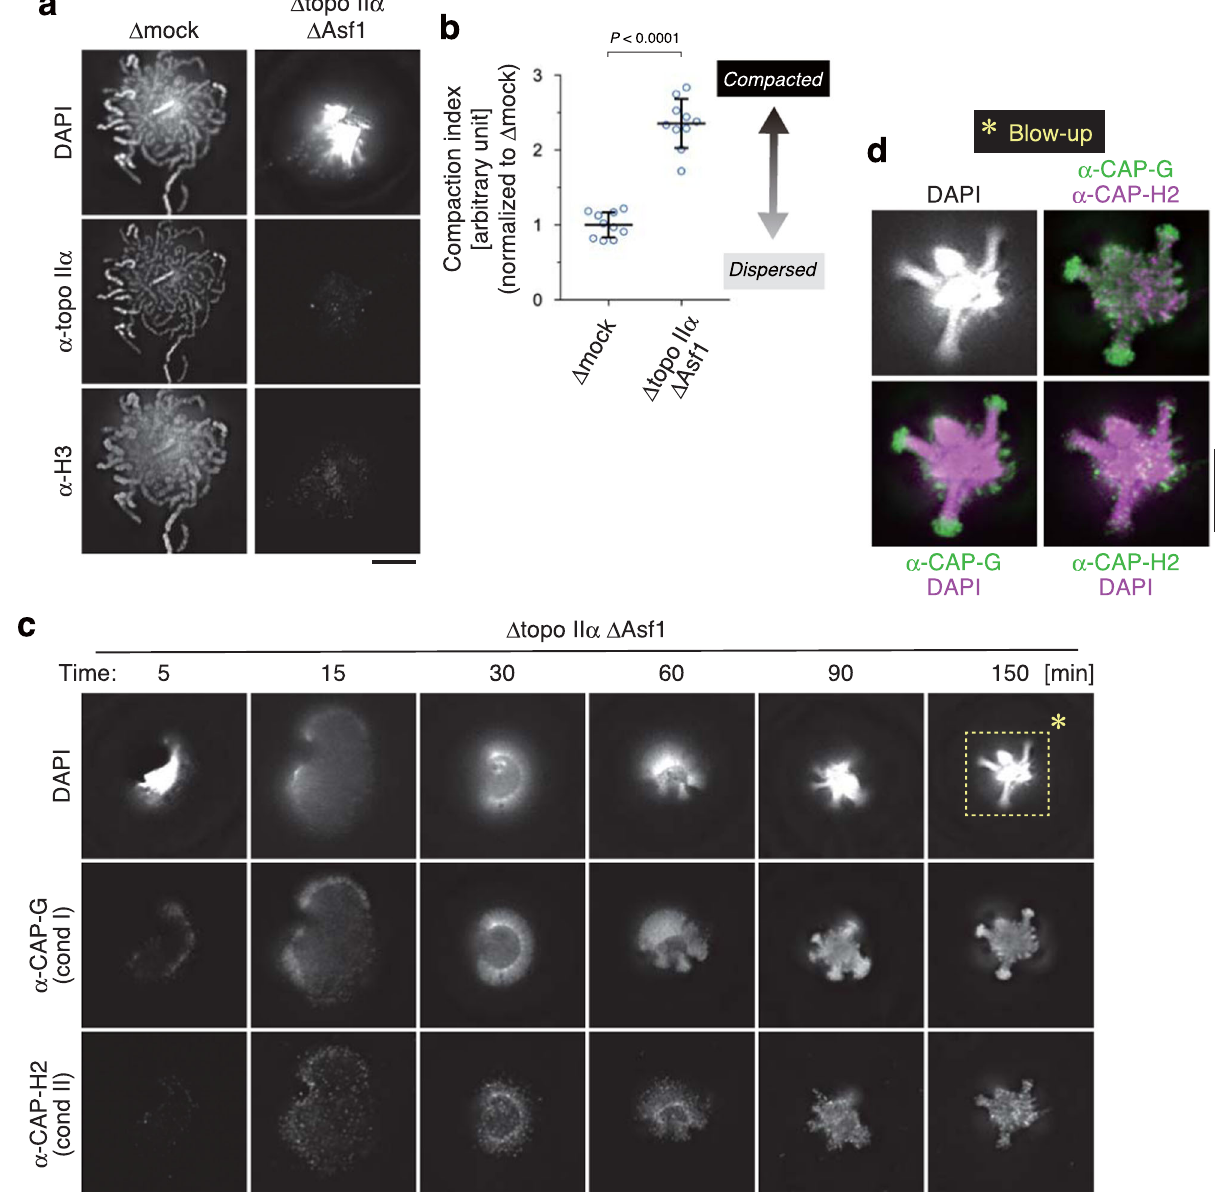
Fig. 4 An unusual chromatin structure is produced in the cell-free extract depleted of both topo II α and Asf1. a , b Mouse sperm nuclei were incubated in a control extract ( Δ mock) or an extract depleted of both topo II α and Asf1 ( Δ topo II α Δ Asf1) for 150 min and labeled with antibodies against topo II α and histone H3. DNA was counterstained with DAPI ( a ). The compaction indices (the average DAPI intensities per unit area) are plotted. The mean ± s.d. is shown ( n = 10 clusters of chromatin). P values were assessed by two-tailed Welch ’ s t -test ( b ). c , d Mouse sperm nuclei were incubated in the Δ topo II α Δ Asf1 extract at 22 °C. At the indicated time points, the reaction mixtures were fi xed and labeled with antibodies against CAP-G (a condensin I subunit) and CAP-H2 (a condensin II subunit). DNA was counterstained with DAPI. This experiment was repeated three times with similar results ( c ). Blow-up images of the cropped part (indicated by the dashed rectangle in the original DAPI image at 150 min) are shown in grayscale (DAPI) and pseudo-colors (merged images for the indicated combinations) ( d ). Bars, 5 µ